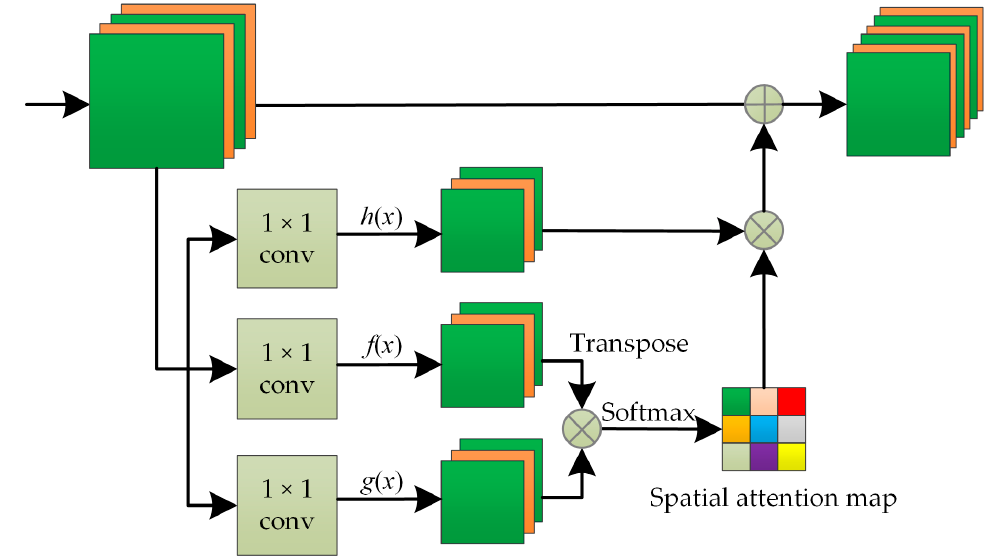
Figure 6. The structure of the spatial attention module.